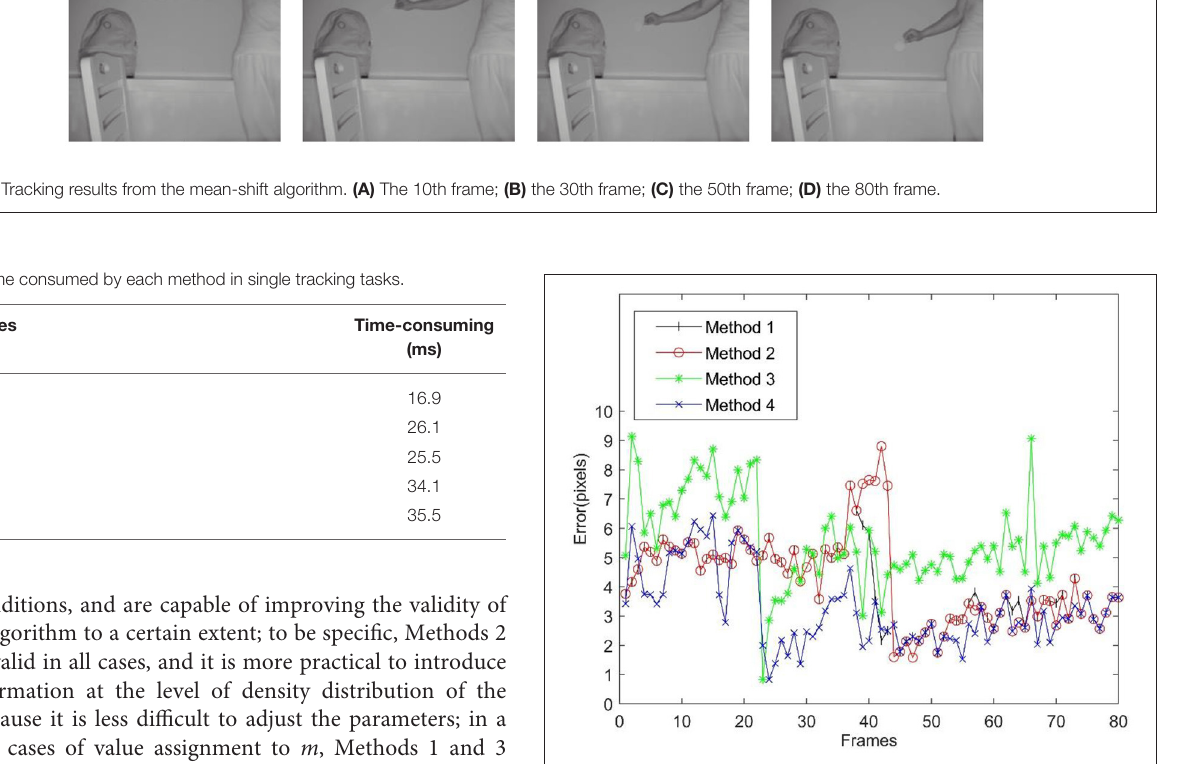
FIGURE 8 | Tracking errors of improvement